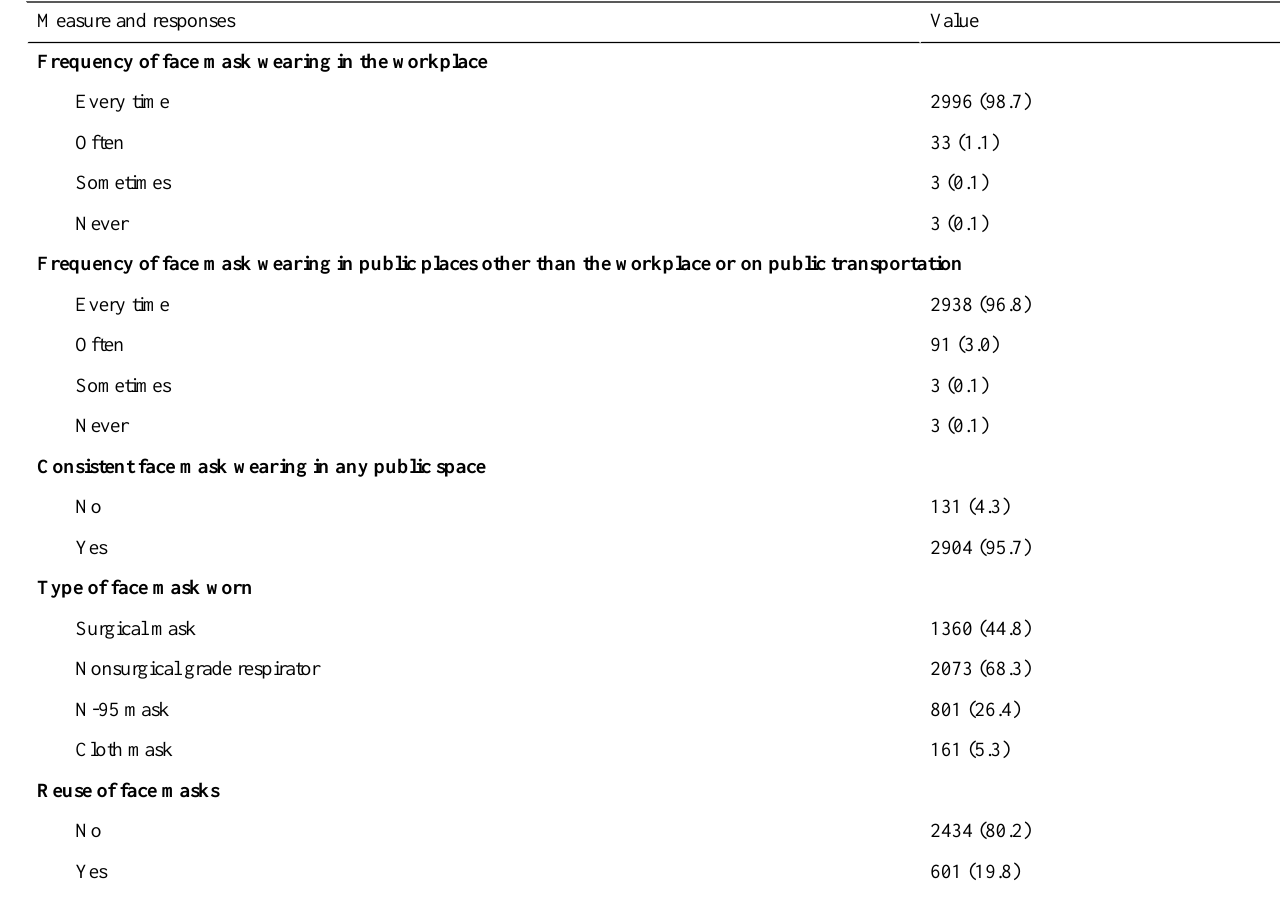
Table 3, Table 4, and Table 5 show the responses to the survey items Table 2. Self-reported compliance with personal preventive measures related to COVID-19 (N=3035), n